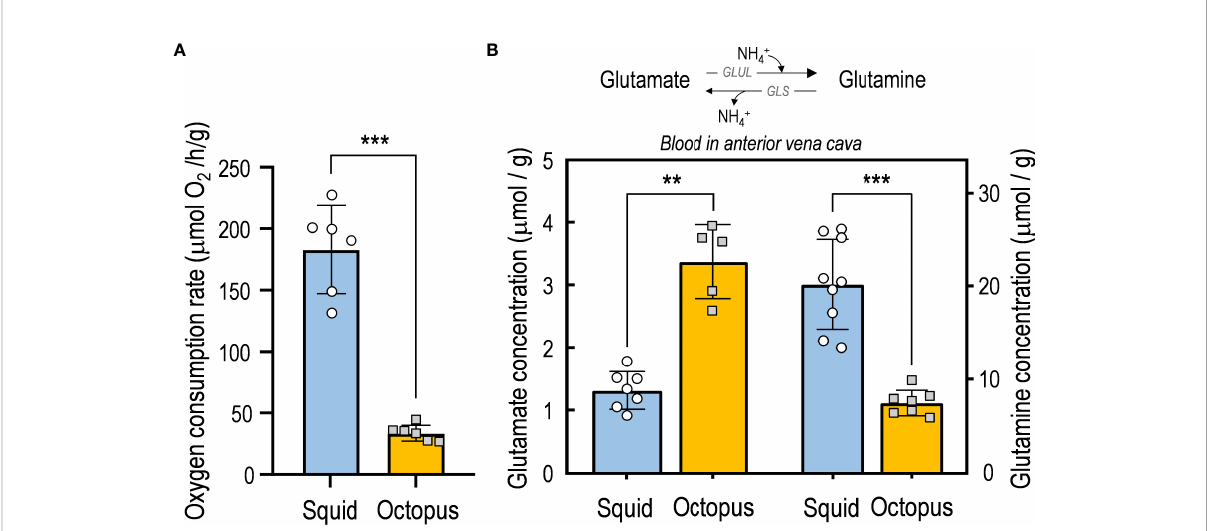
FIGURE 2 Metabolic features in squid and octopus. (A) The resting metabolic rates (RMRs) of adult big fi n reef squid ( S. lessoniana ) and common octopus ( O. vulgaris ) were evaluated by measuring their oxygen consumption rates under the animals were incubated in a closed swim tunnel with continuous water fl ow. (B) The glutamate and glutamine contents in blood were collected from the anterior vena cava. The estimated values are presented as mean ± SD (n = 5~9). Asterisks indicate signi fi cance levels of p < 0.01 (**) and p < 0.001